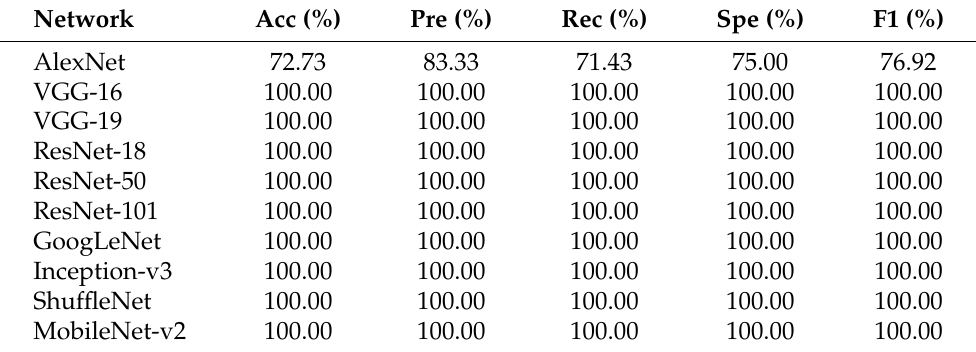
Table 2. CNN performance obtained with the original ALL-IDB1 test set.